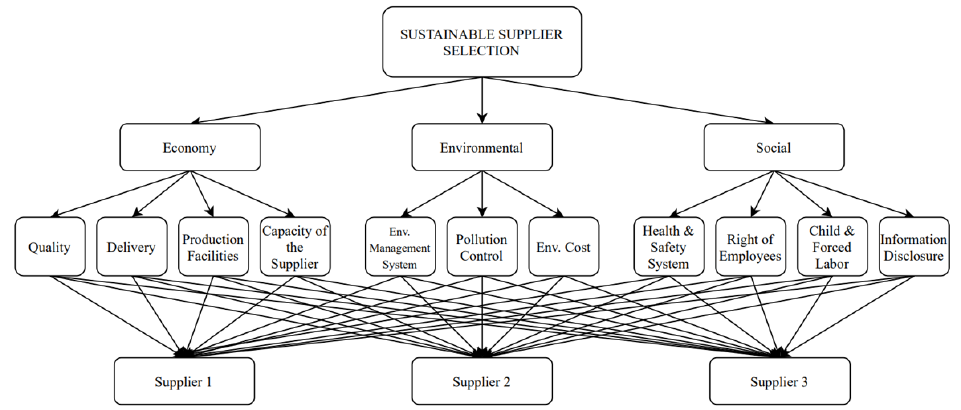
Figure 2. Hierarchy of the sustainable supplier selection.